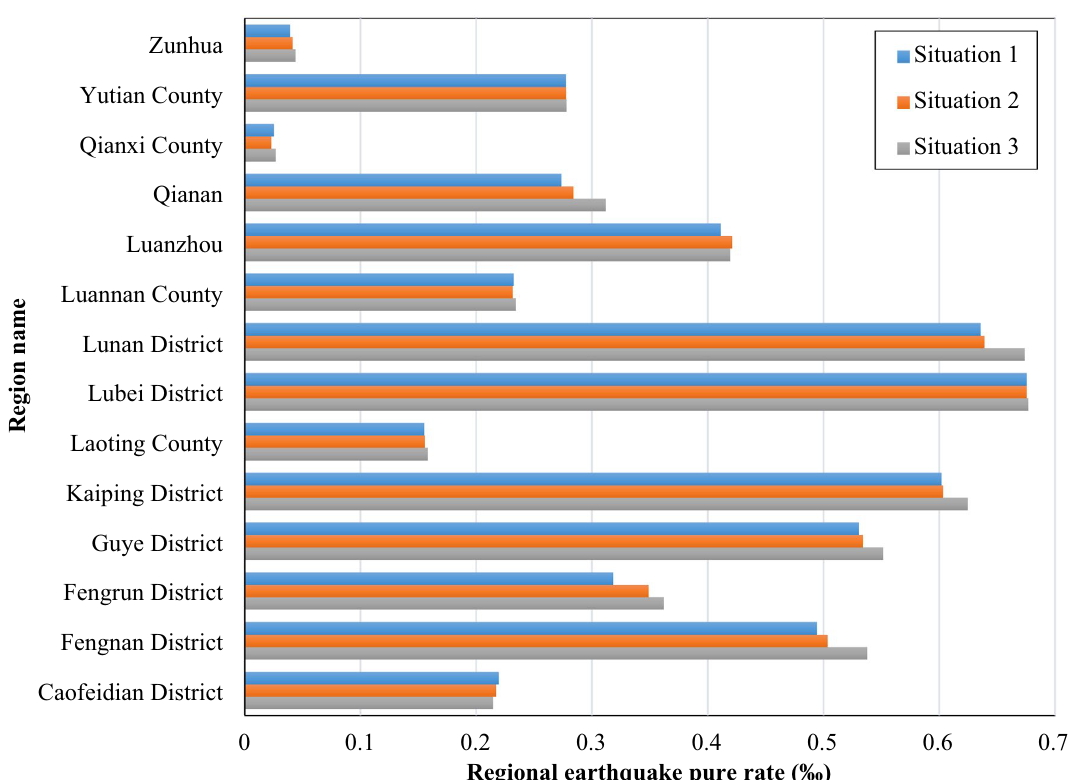
Fig. 6 Histogram of comparison of rates in Tangshan City under three